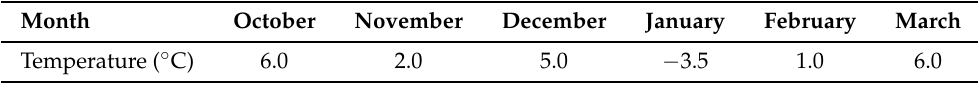
Table 3. Surface air temperature at the time of